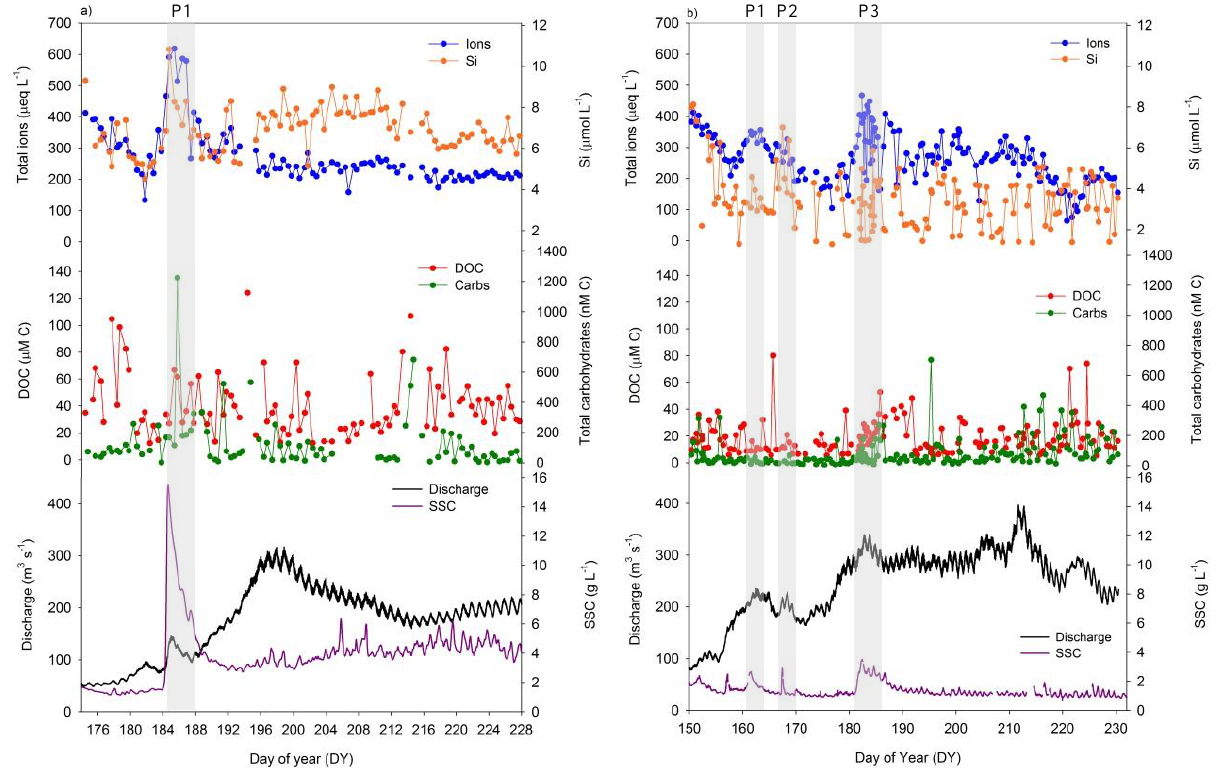
Figure 2. Export of major inorganic (total ions and dissolved silica) and organic (DOC and free carbohydrates) compounds in Leverett Glacier bulk runoff in the 2009 melt season (a) and the 2010 melt season (b) . Total discharge and suspended sediment concentration (SSC) are also plotted. The approximate timing of water pulses that punctuate the discharge hydrograph (P) and which are associated with a rise in solutes is denoted by shading. P1(2010) is synonymous with P4 in Bartholomew et al. (2011). Outliers ( ≥ mean ± 3 × standard deviation) have been excluded from the time series and DOC concentrations on DY 166.33 and 217.75 excluded from mean